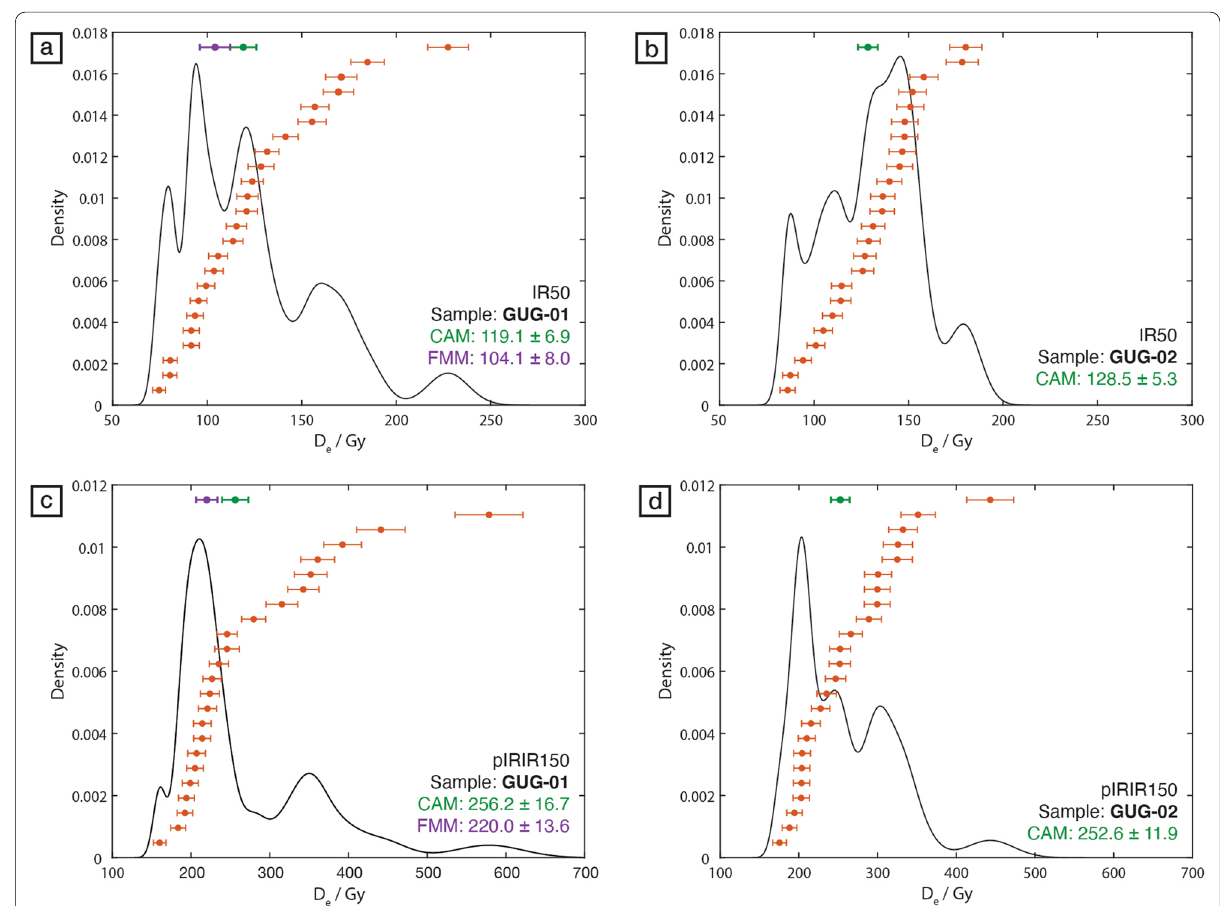
Fig. 8 Density plot of the uncorrected luminescence D e distribution of sample GUG20-01 ( a and c : IR 50 and pIRIR 150 measurements, respectively) and GUG20-02 ( b and d : IR 50 and pIRIR 150 measurements, respectively). D e obtained by applying the CAM and FMM (only for GUG20-01) on the D e distributions are shown in green and purple,